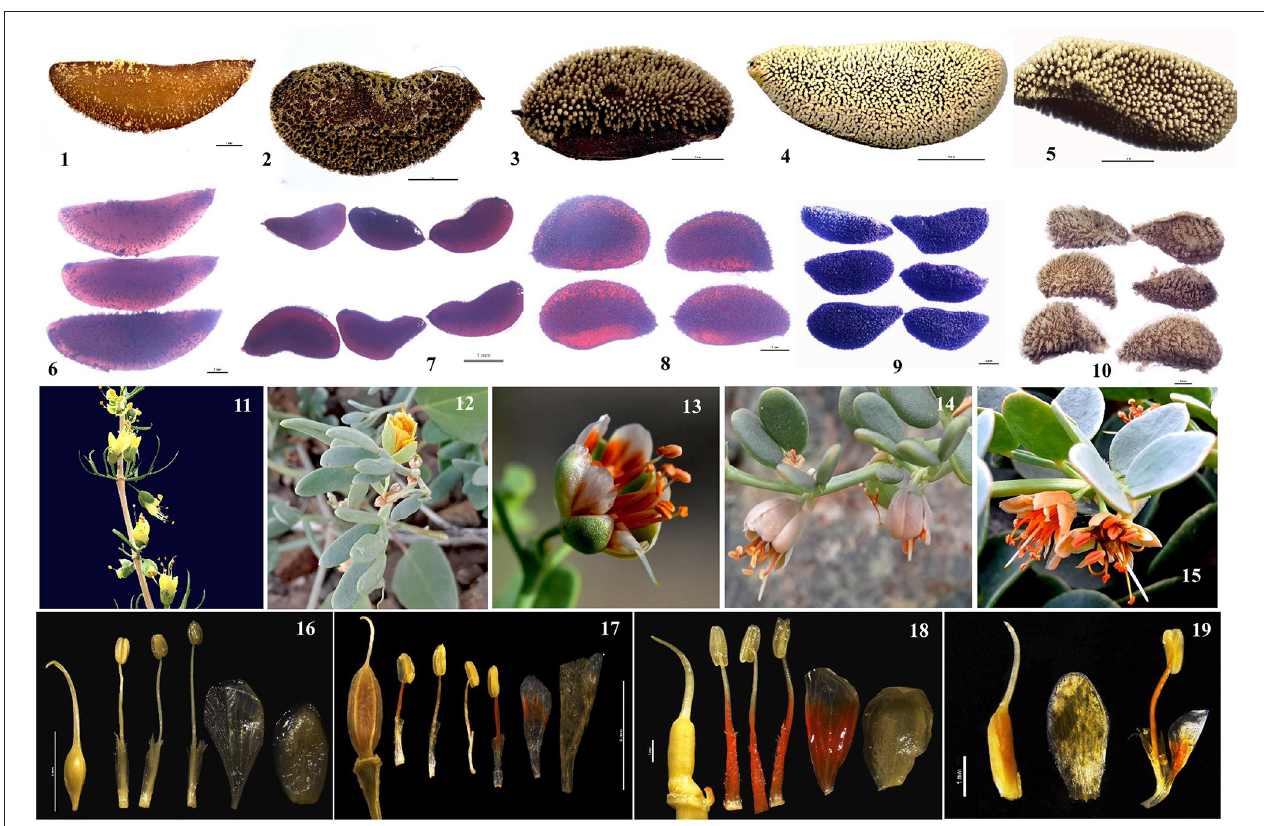
FIGURE 8 | The morphological variation of species in Zygophyllum . Morphological characteristics of species of Zygophyllum representing the clade of woody shrubs ( Z. xanthoxylon_b : 1, 6, 12, 17) and herbaceous species of the basal grade ( Z. potaninii: 10,16; Z. sinkiangense : 11) and subclades I ( Z. rosowii : 4, 8, 15, 20), II ( Z. pterocarpum : 3, 9, 13, 18; Z. neglectum:5 ), and III ( Z. fabago : 2, 7, 14,